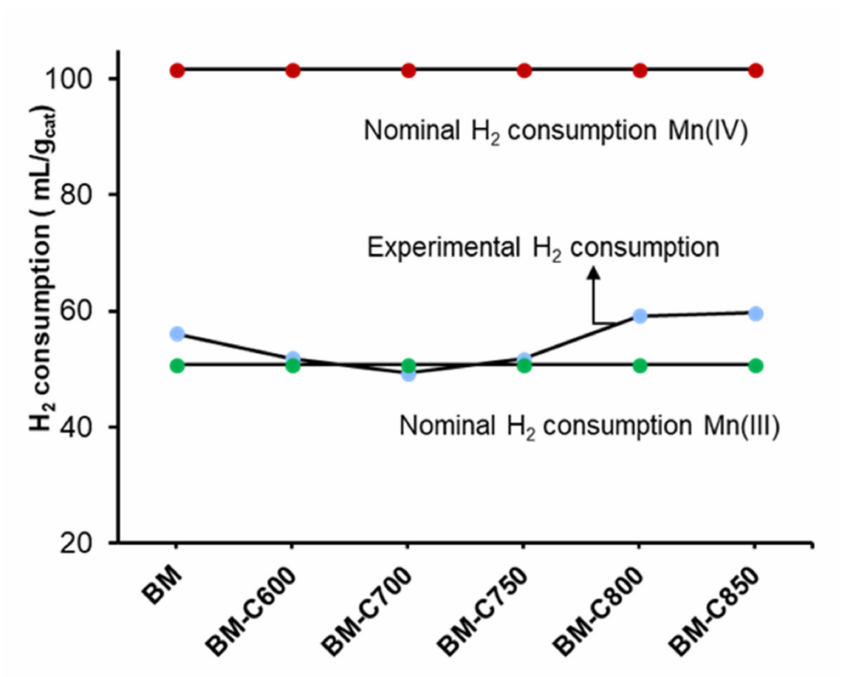
Figure 7. Hydrogen consumption between 150–500 ◦ C, corresponding to manganese